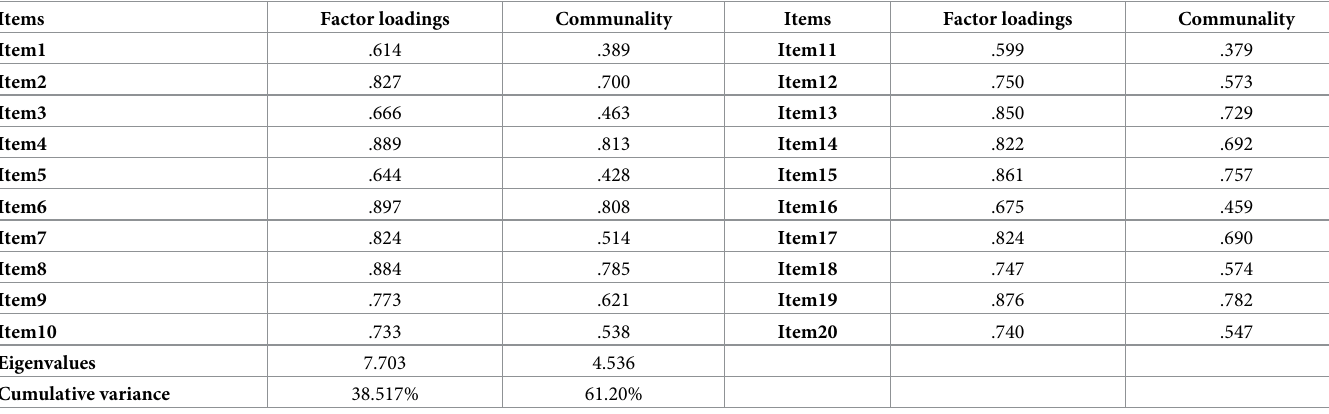
Table 2. Standardized factor loadings and communality of the Chinese version of